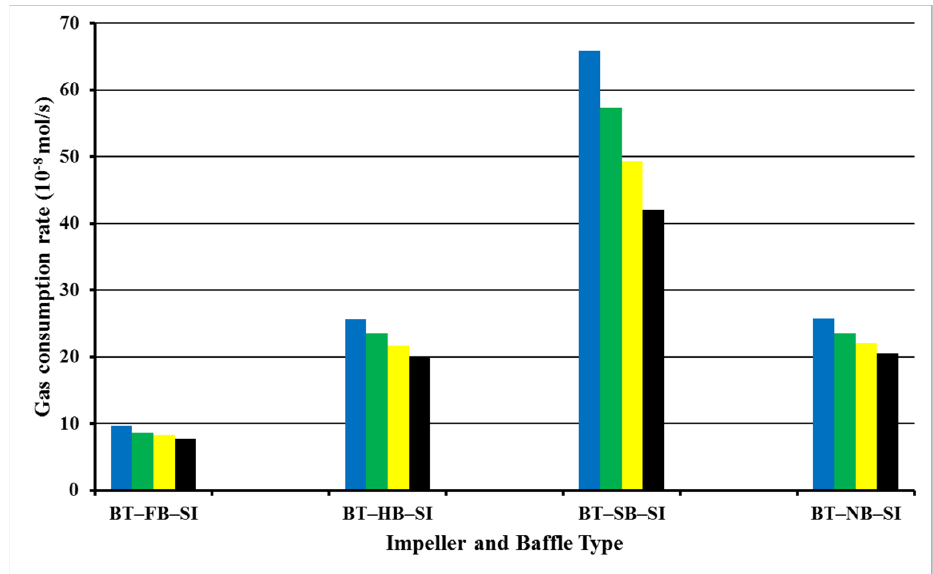
Figure 2. Rate of gas consumption or equivalent hydrate formation in single-impeller experiments at starting rotation conditions of 2 °C and 42.5 bars for 1 s (blue), 600 s (green), 1200 s (yellow), and 1800 s (black).